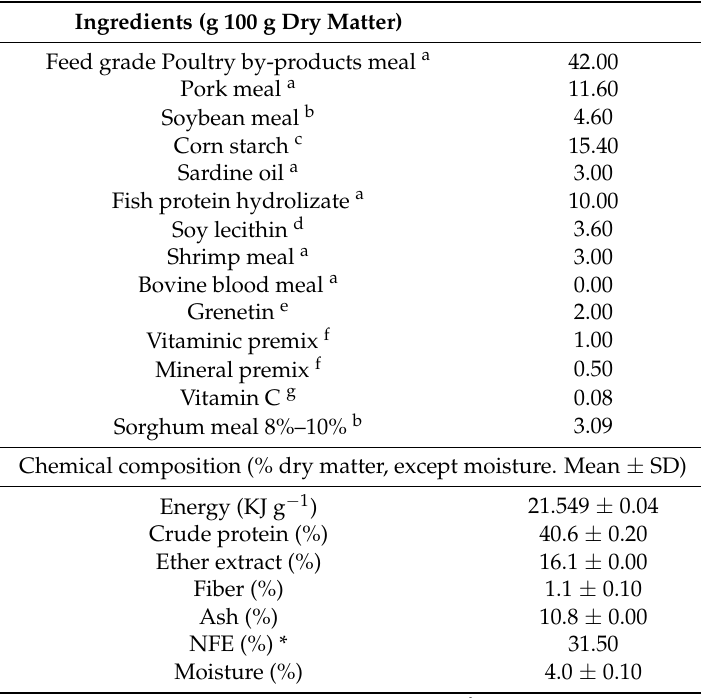
Table 3. Chemical composition of the formulated diet for juveniles of A. tropicus